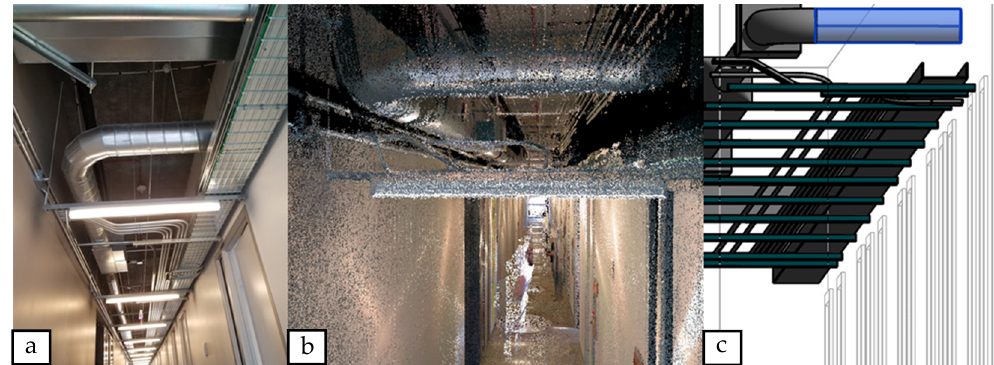
Figure 1. ( a ) Photograph of the built environment, ( b ) laser scan, and ( c ) resultant model. Approximate test area physical dimensions are 5 ft. wide by 25 ft. long.